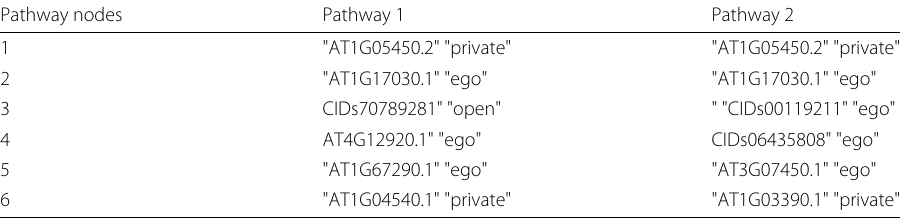
Table 11 Two shortest paths of length 6: the first one contain nodes that reach non-egocentric area and the second one is completely inside the egocentric network Pathway nodes Pathway 1 Pathway